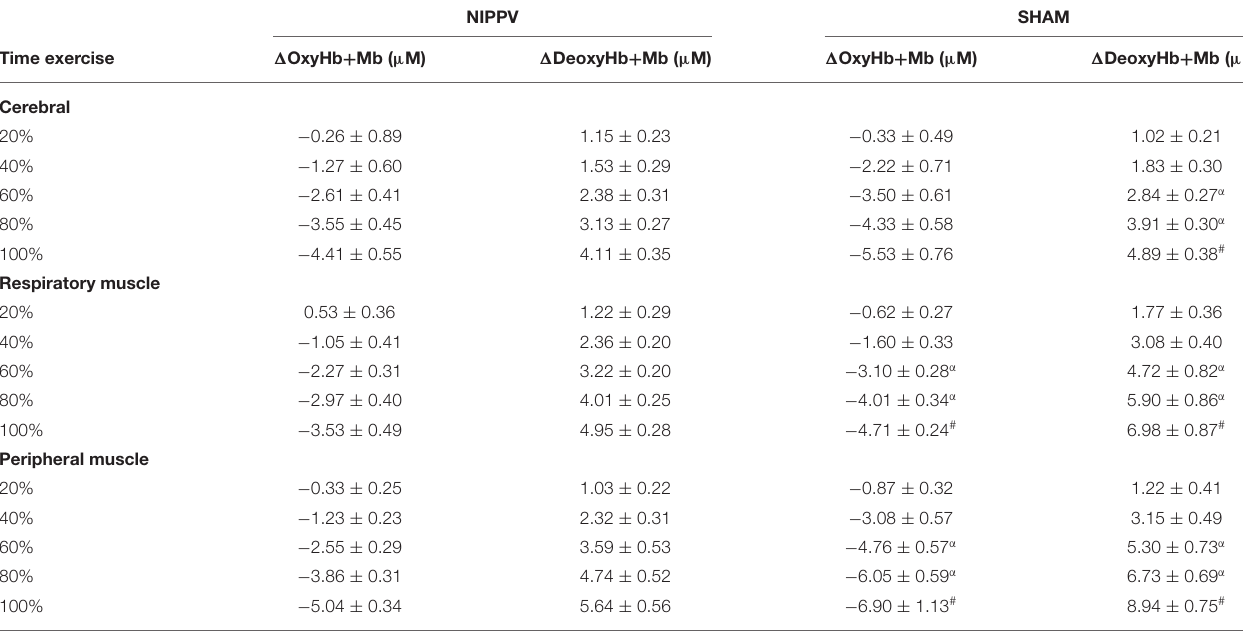
TABLE 2 | Cerebral, respiratory, and peripheral 1 OxyHb + Mb and 1 DeoxyHb + Mb values during high-intensity exercise in patients with COPD-HF. NIPPV SHAM Time